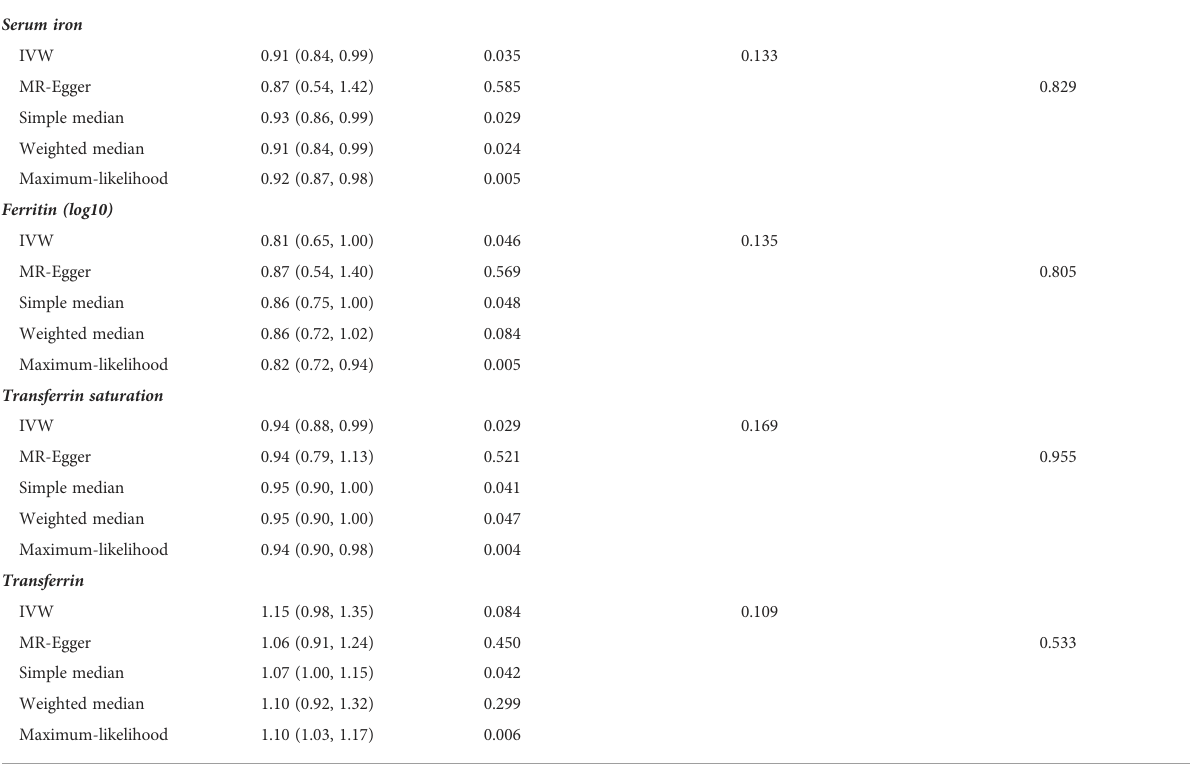
TABLE 1 MR analysis estimates for each iron biomarkers on the risk of prostate cancer among European